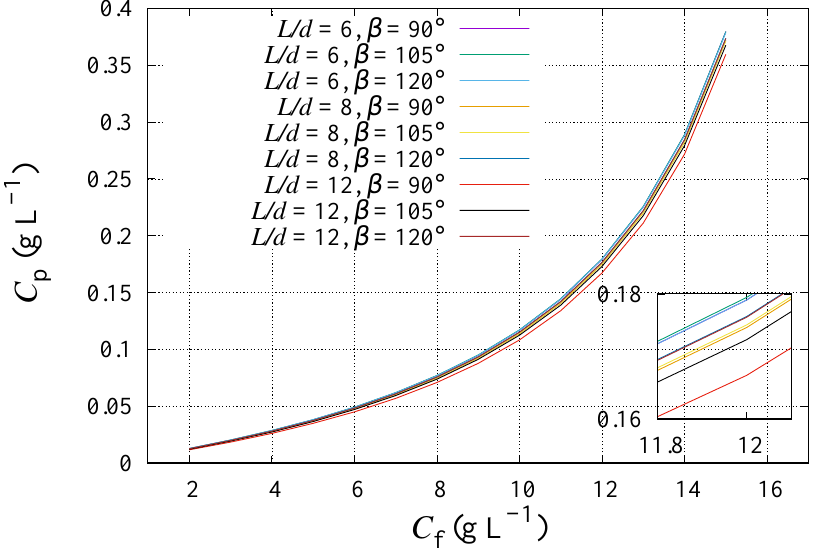
Figure 5. C p of the membrane FILMTEC TM BW30-400 considering different feed spacer geometries, a range of C f , p f = 15 bar and Q f = 11 m 3 h − 1